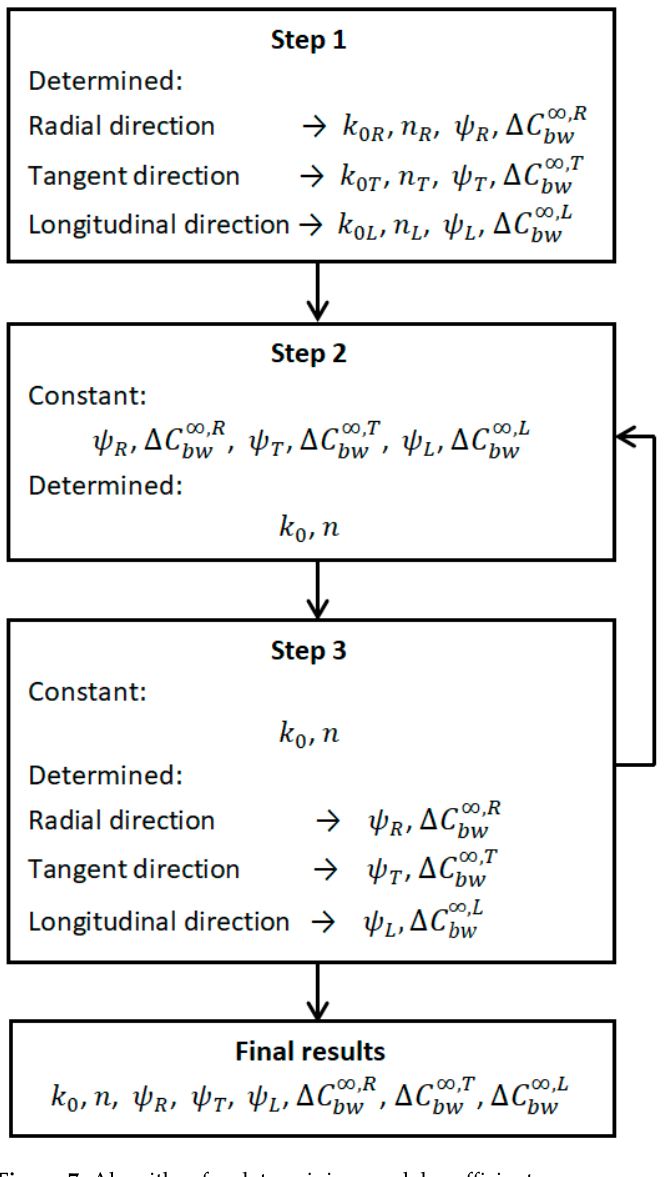
Figure 7. Algorithm for determining model coefficients. Table 3. Matching errors of the final results and of the first calculation stage for the pine samples.